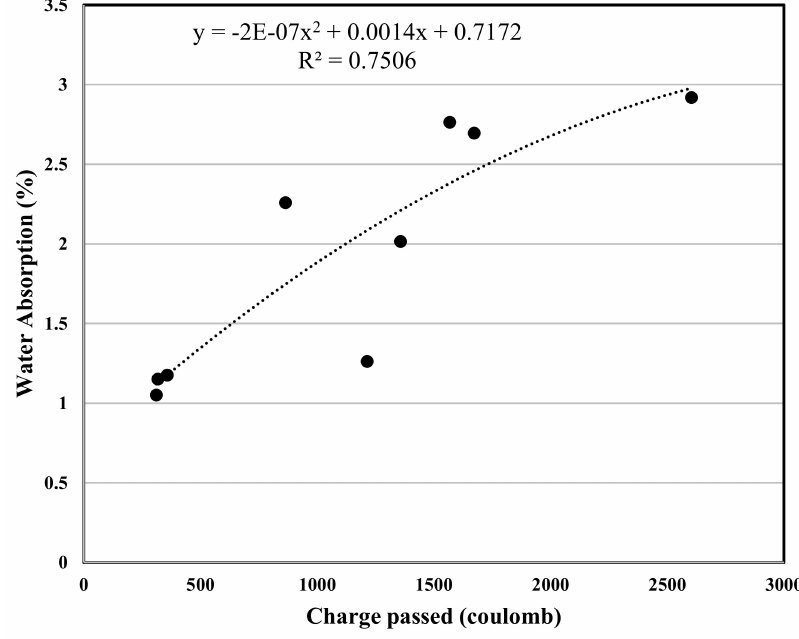
Figure 12. Correlation between charge passing and water